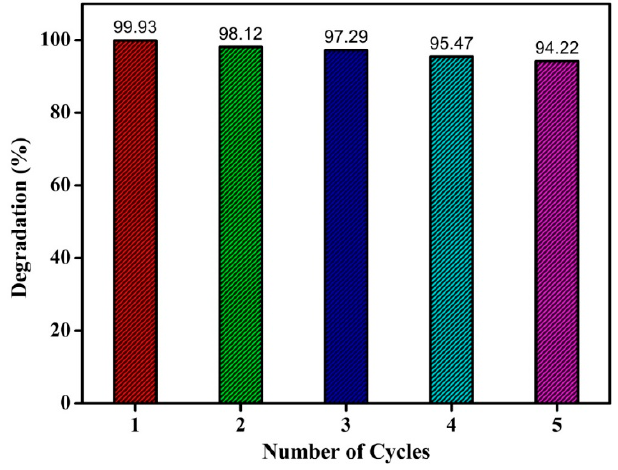
Figure 8. Reusability of the TU4 for MO degradation under UV light irradiation.